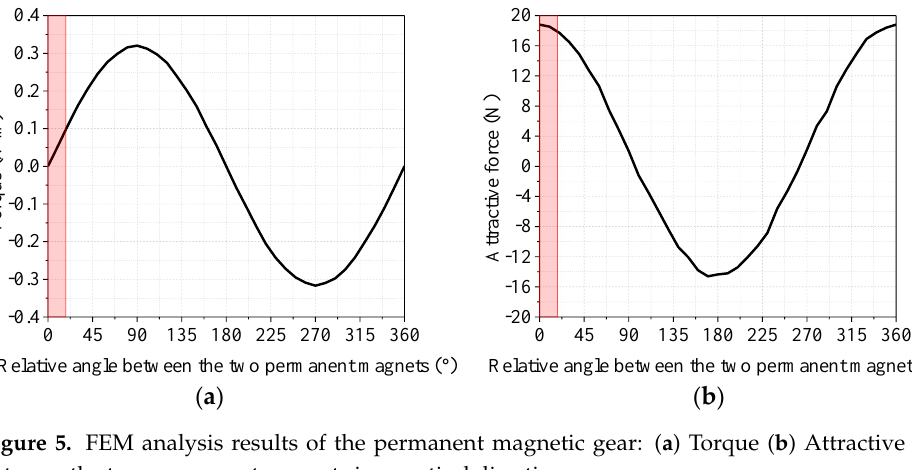
Figure 5. FEM analysis results of the permanent magnetic gear: ( a ) Torque ( b ) Attractive force between the two permanent magnets in a vertical direction.